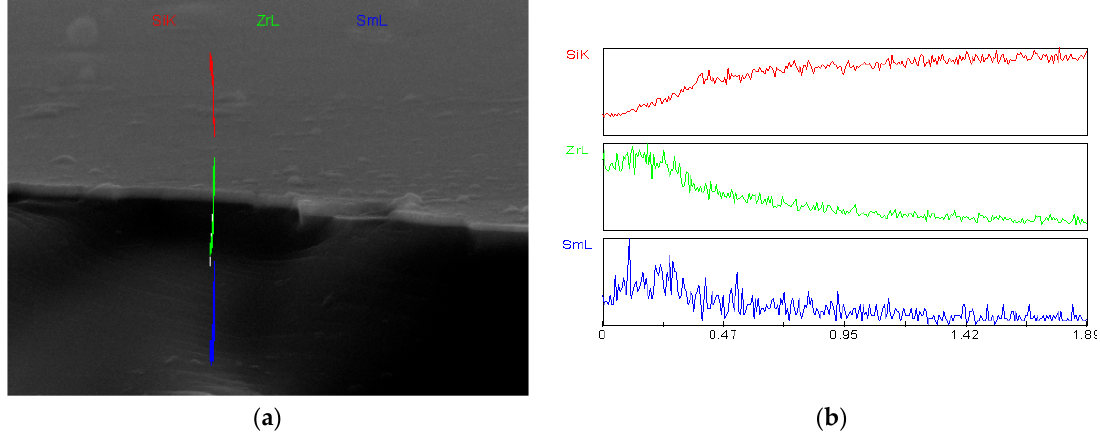
Figure 4. EDS line scan analysis performed on the cross-section of the layer shown in Figure 1. ( a ) The cross-section of the layer and the substrate and ( b ) linear analysis of its chemical composition (EDS).